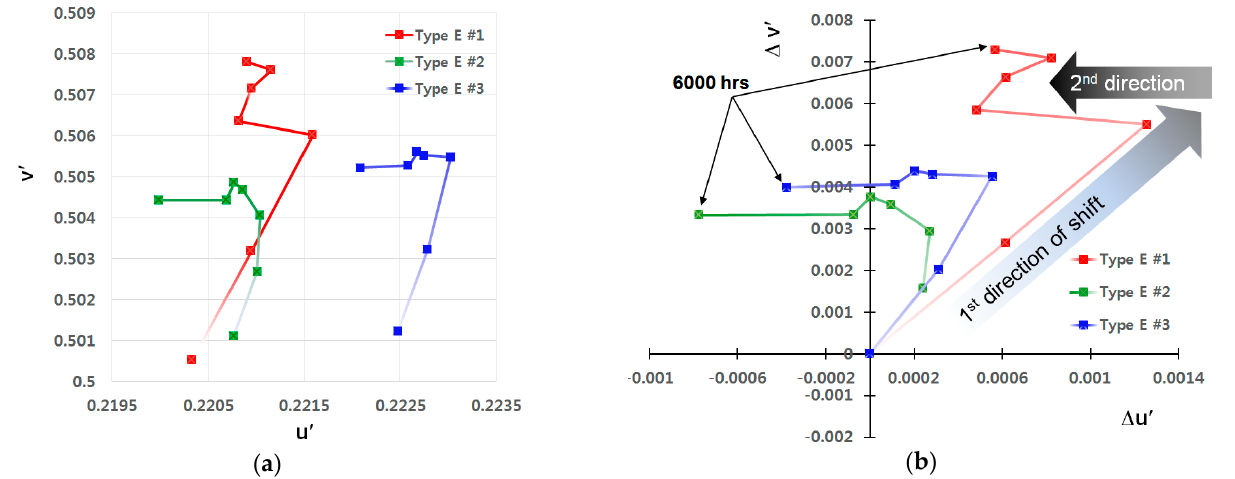
Figure 6. Color shift of OLED luminaire type E. ( a ) u’ and v’ color shift of luminaire type E. ( b ) ∆ u’ and ∆ v’ variations of luminaire type E.